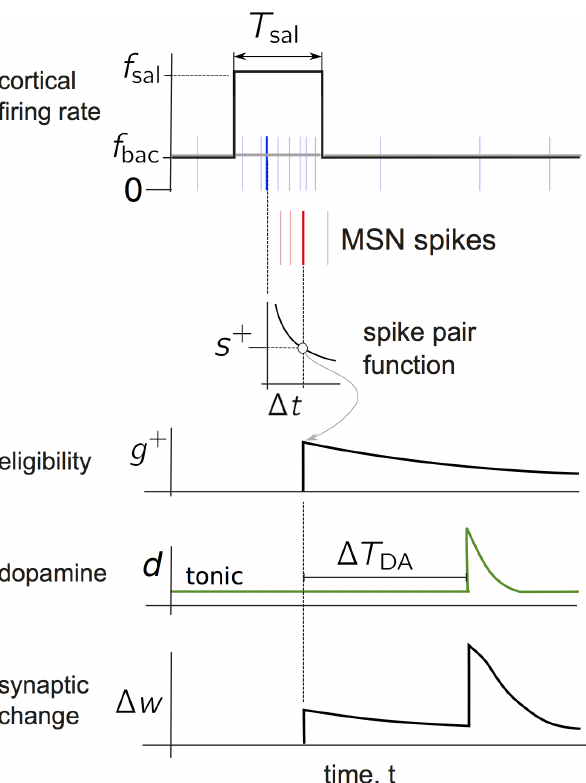
Figure 6. Cartoons of signals during a single trial of action learning. The top panel shows the firing rate of cortical neurons afferent to a particular MSN, and taking part in an action request. Afferent subset S , is distinguished by a higher firing rate f sal (solid black line) during the request, and its set complement, (cid:2) SS , has afferents with rates at background levels f bac (grey line). The action request lasts for some period, T sal , and outside this period, all afferents receive spikes at rate f bac . Typical cortical spikes are shown in blue with one highlighted in a darker hue. Just below these are shown a typical MSN response, (spikes in red, one highlighted in darker hue). The highlighted spike pair has an ISI of D t and elicits an contribution s z ( D t ) to the eligibility trace g z (promoting LTP in this case). The eligibility interacts with the dopamine signal to produce a contribution to the change D w in synaptic strength. Notice that the phasic dopamine signal occurs at a time D T DA after the spike pair which is much longer than the time constant for the STDP